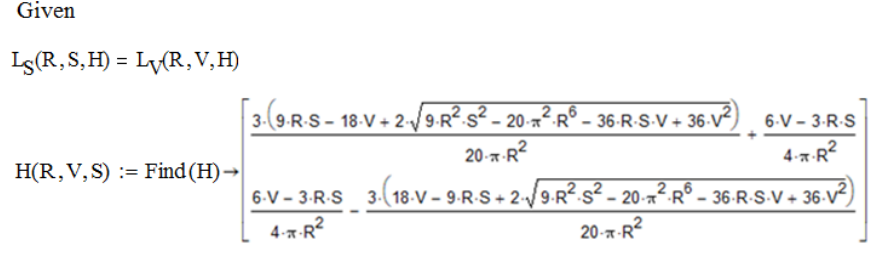
Figure 15. Listing for the solution of Equation (18).